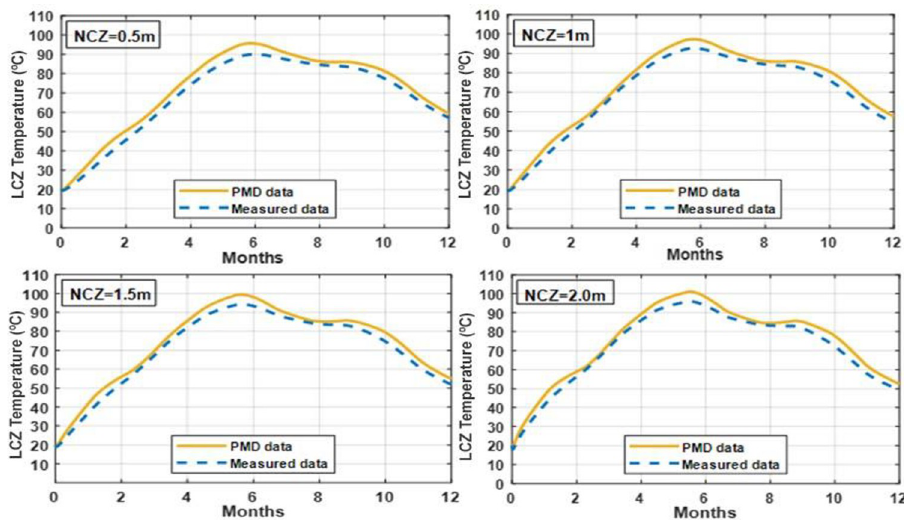
Fig 13. Effect of different thickness of NCZ on the temperature of LCZ with UCZ = 0.3 m and LCZ = 0.7 m for whole year simulation under PMD and measured climatic conditions of Lahore.